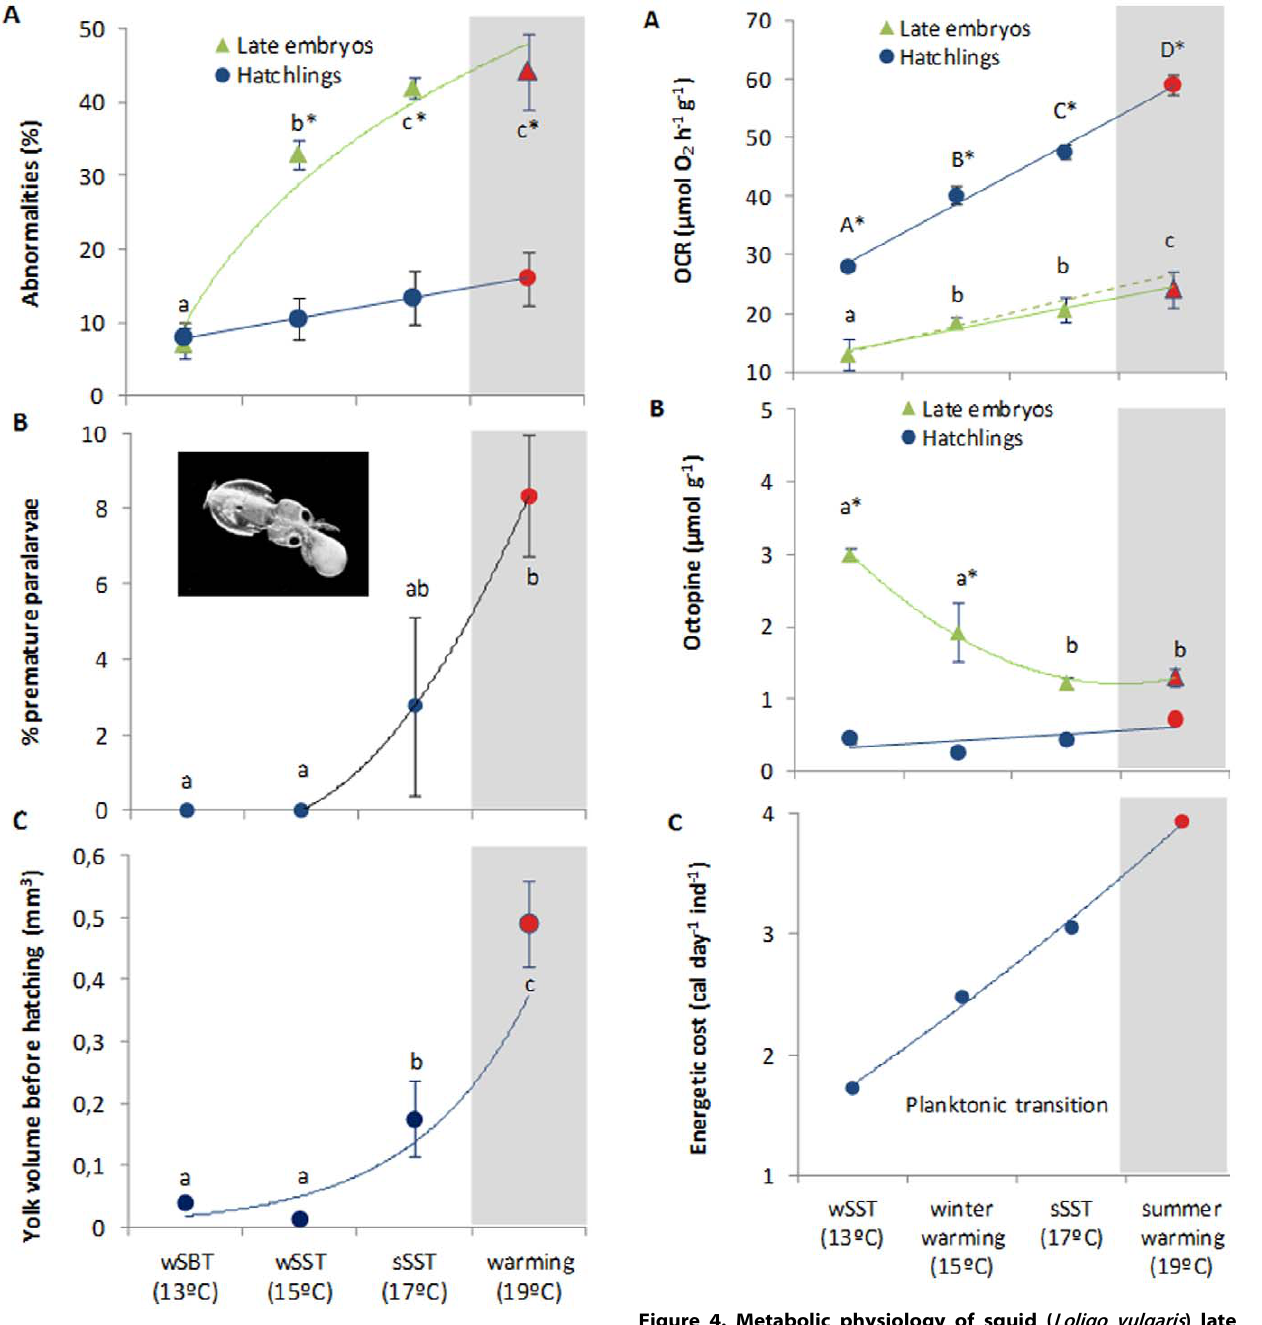
Figure 3. Abnormalities and premature hatching in the squid, Loligovulgaris . Percent of total abnormalities (%) in late embryos and hatchlings (A), percentage of premature paralarvae (B), and yolk volume in late embryos (mm 3 )(C) at the different temperature scenarios (red symbols highlight the future summer scenario). Values are mean 6 SD. Colored lines represent trendlines. In the upper panel, different letters and asterisks represent significant differences between temperatures and developmental stages, respectively (two way-ANOVA, more statistical details in Supporting Tables). In the middle and lower panels different letters represent significant differences (one-way ANOVA; more statistical details in Supporting Tables).